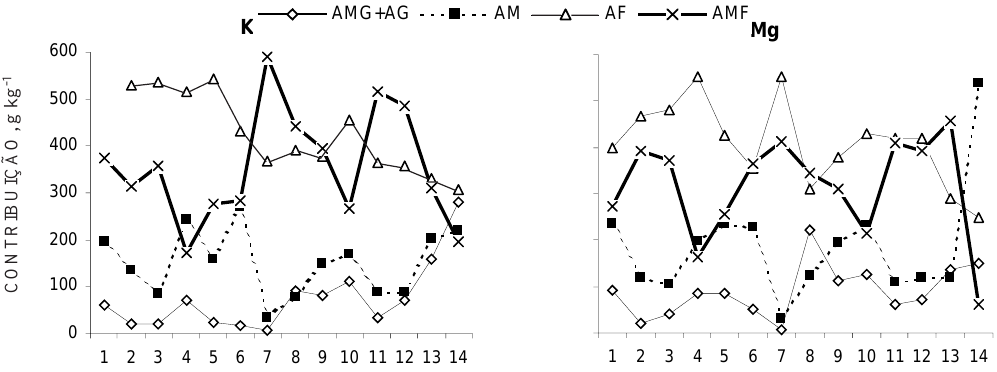
Figura 3. Contribuição das diferentes classes de tamanho da fração areia (AMG-areia muito grossa, AG- areia grossa, AM- areia média, AF-areia fina e AMF-areia muito fina) nos teores totais de K e Mg da areia leve